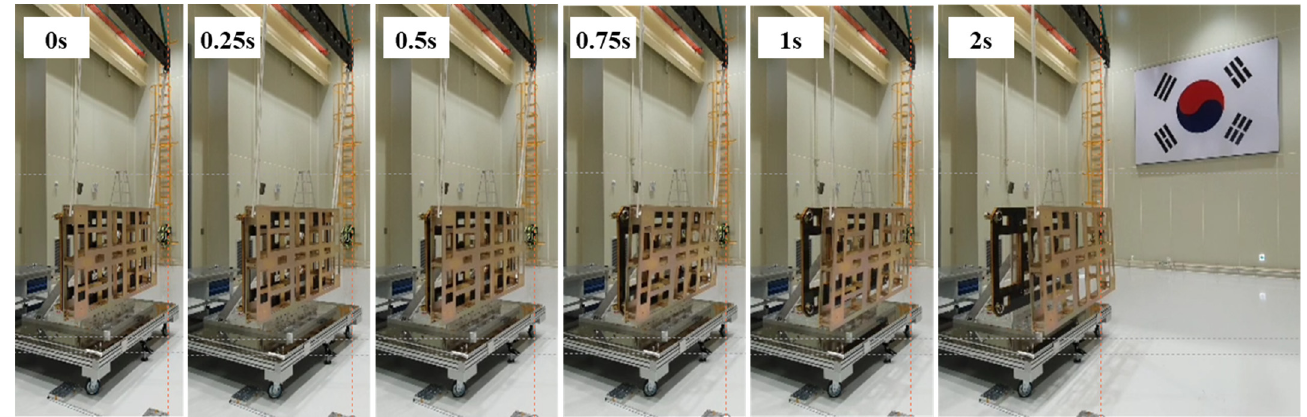
Figure 21. Satellite separation test result with respect to each time interval.